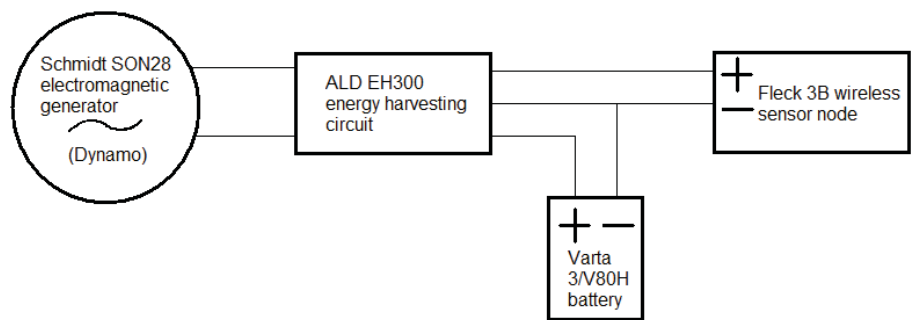
Figure 6. Electrical schematic of generator, energy harvesting circuit, battery and wireless sensor